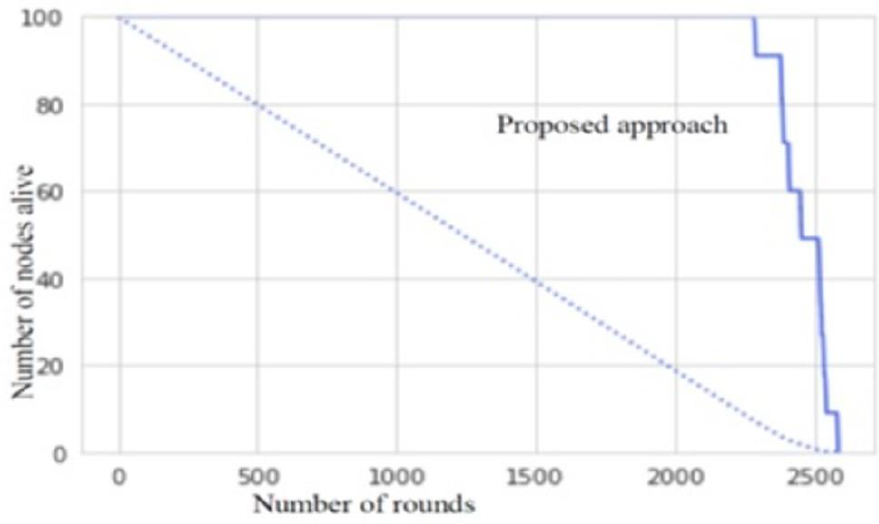
Figure 7. Number of rounds vs. number of nodes alive.